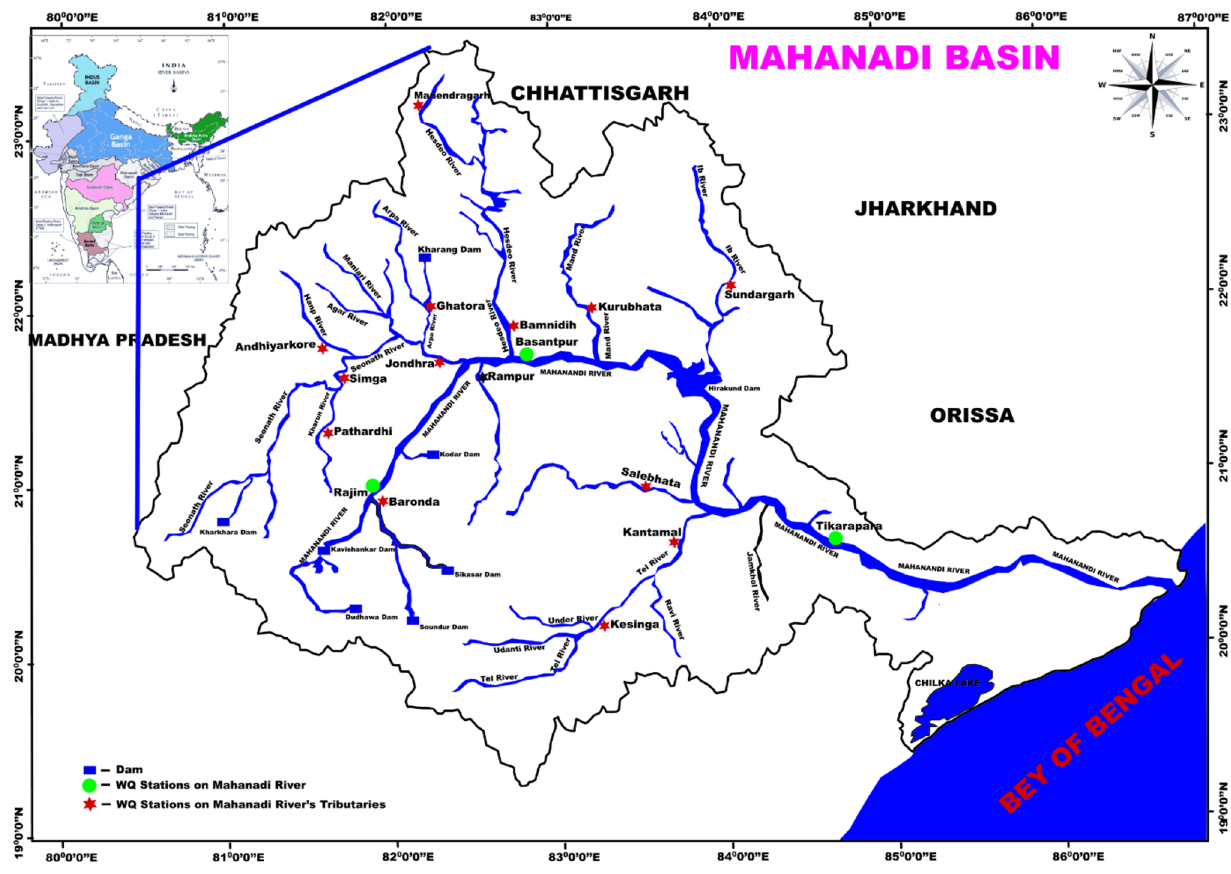
Fig. 1 Map showing detailed view of Mahanadi River, its tributaries, and sampling